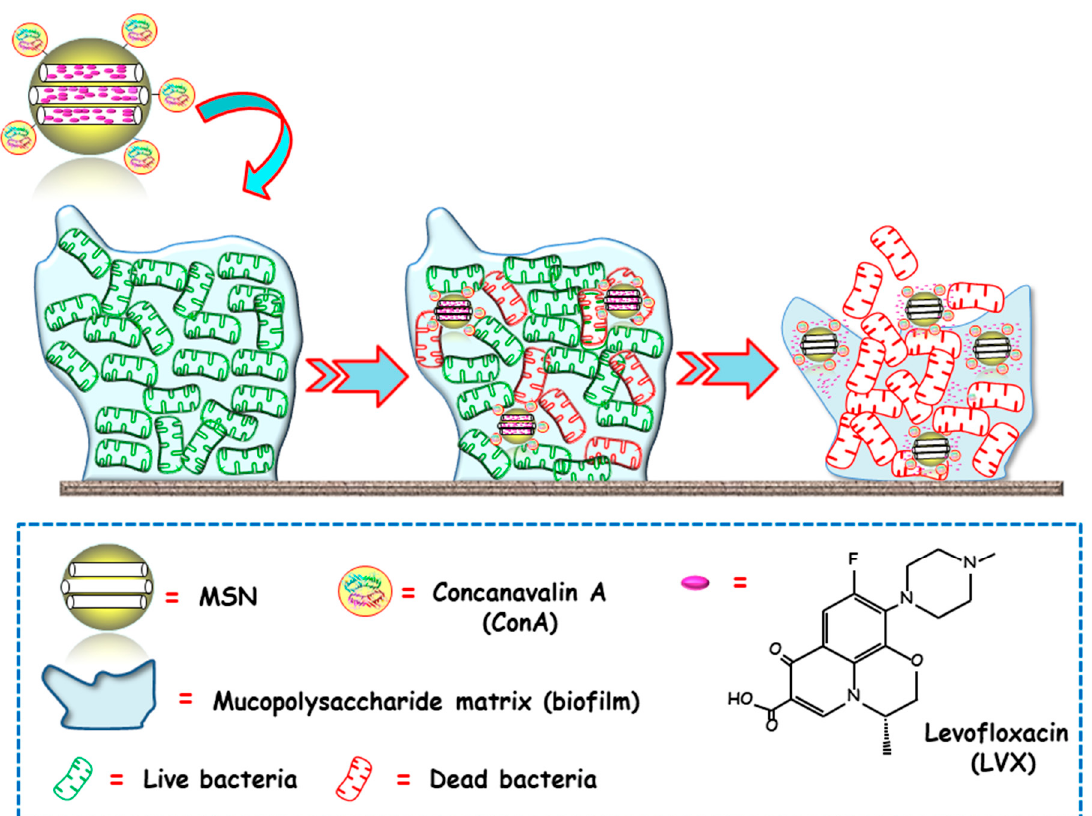
Figure 3. Schematic representation of the operating mechanism of bacterial biofilm-targeted antimicrobial nanosystems consisting of MSNs loaded with levofloxacin (LVX) and functionalized with the biofilm targeting agent Concanavalin A (ConA). Adapted from ref. [69]. Con A, with a ffi nity towards certain components of the mucopolysaccharide matrix in biofilm, drives MSNs penetration into the biofilm and allows the release of the antibiotics inside to achieve antimicrobial effect.